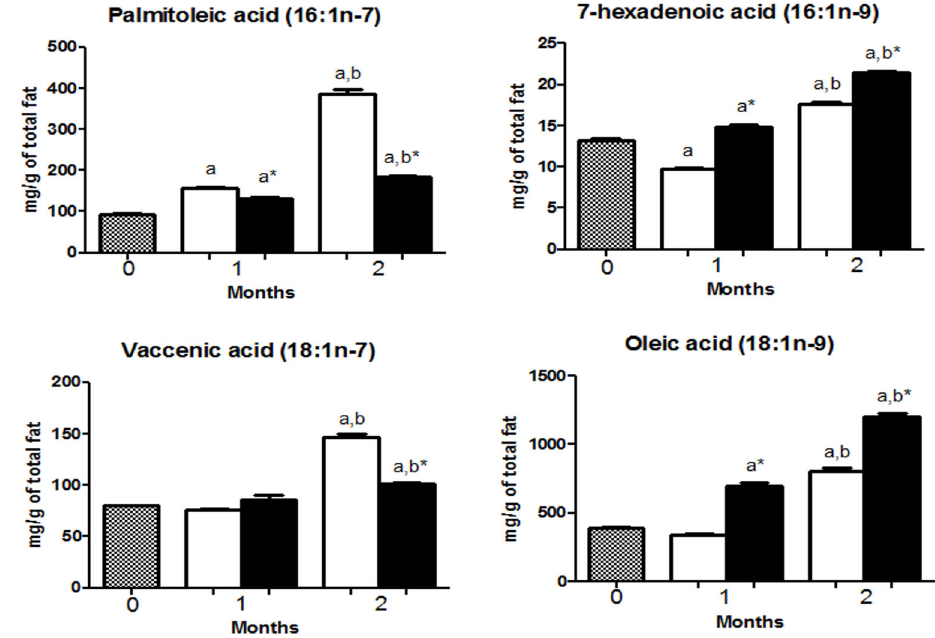
Figure 3. Monounsaturated fatty acids (MUFAs) composition in the gastrocnemius muscle of mice at 0 (before starting the diets, gray bars) or fed with a high-carbohydrate diet (HCD, white bars) or high-fat diet (HFD, black bars) for 1 or 2 months. The concentrations of MUFAs are reported as means ± SE. *P o 0.05 compared to HCD group (Student ’ s t -test). a P o 0.05 compared to time 0; b P o 0.05 compared to 1 month (one-way